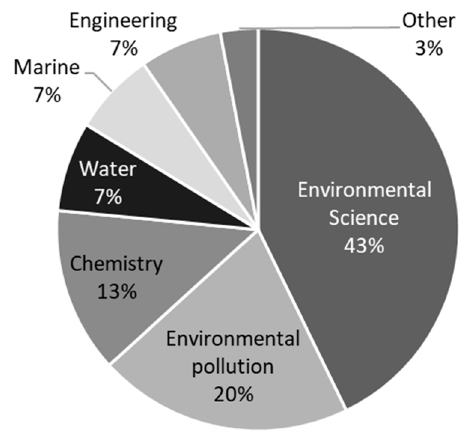
Figure 5. Main discipline of journals in which selected papers were found .